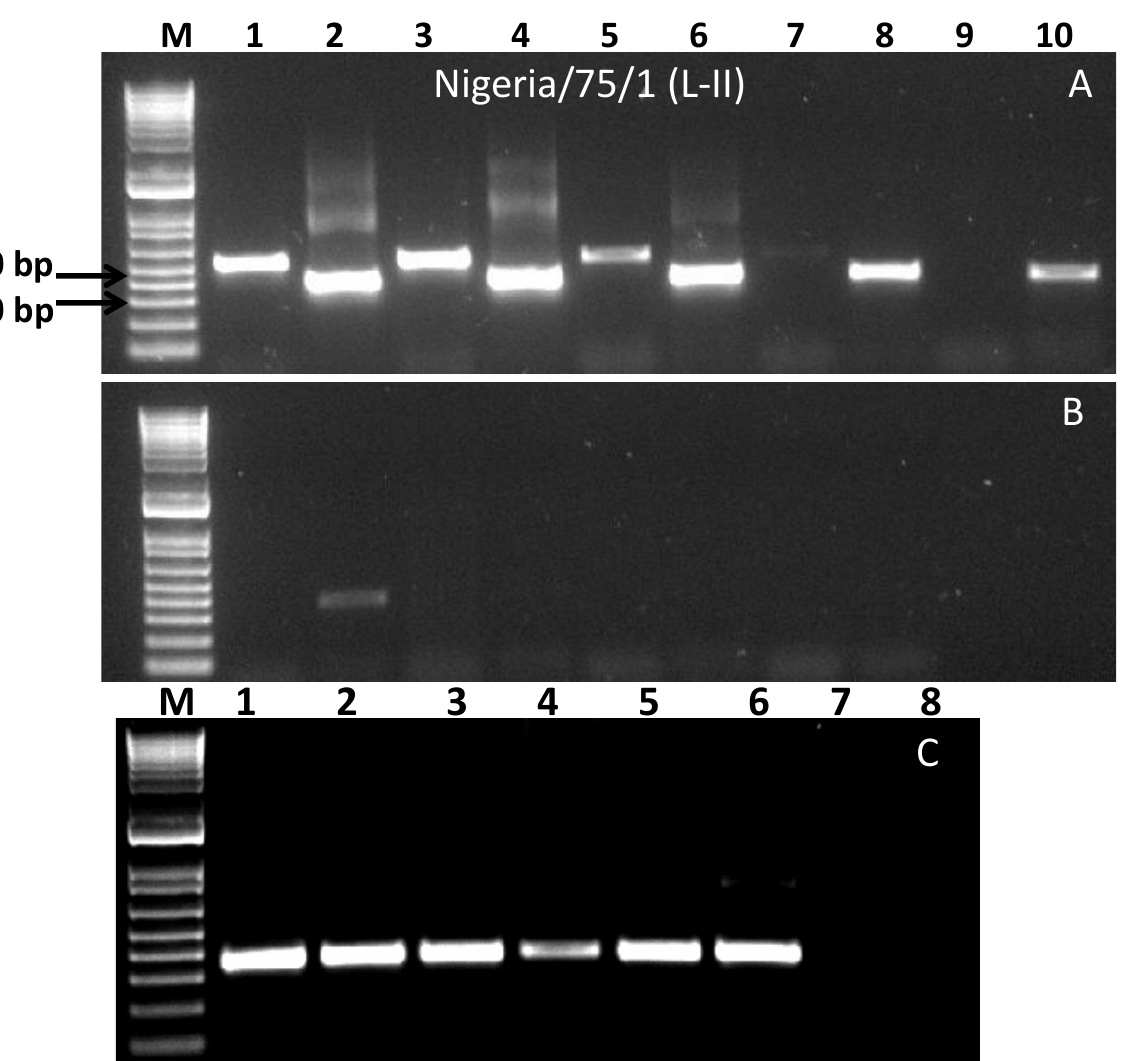
Figure 1. Gel images of PCR products using RNA of Nigeria/75/1 vaccine strain. ( A , B ): PCR products obtained from first round of PCR using primer pair NP3/NP4 (even number lane) and N1197F/N1658R (odd number lane), ( C ): nested PCR products using primer pair NP3/NP4. M: 1 kb plus marker DNA; lanes 1–8: PCR products corresponding to dilution 10 −3 to 10 −10 , respectively. All the odd and even lanes in A , B shows products of primer pair N1197F/N1658R and NP3/NP4, respectively using neat, 10 −1 –10 −10 RNA. Lanes 1–8 in C represents 10 −3 –10 −10 RNA, respectively.